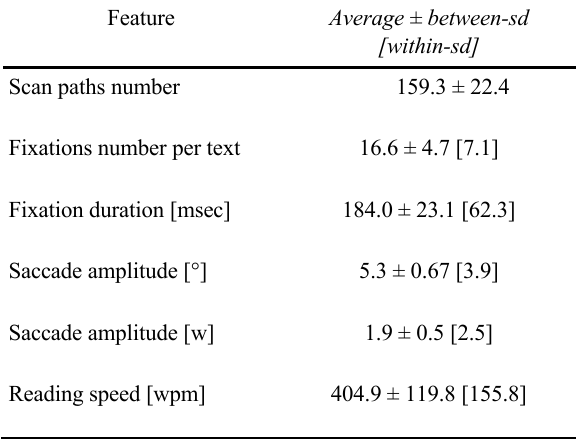
Table 1. Average ± between-participant standard deviation [within-participant standard deviation] for the number of texts, the number of fixations per text, the fixation duration, the saccade amplitude in [°] and in number of words [w], and the reading speed [wpm]